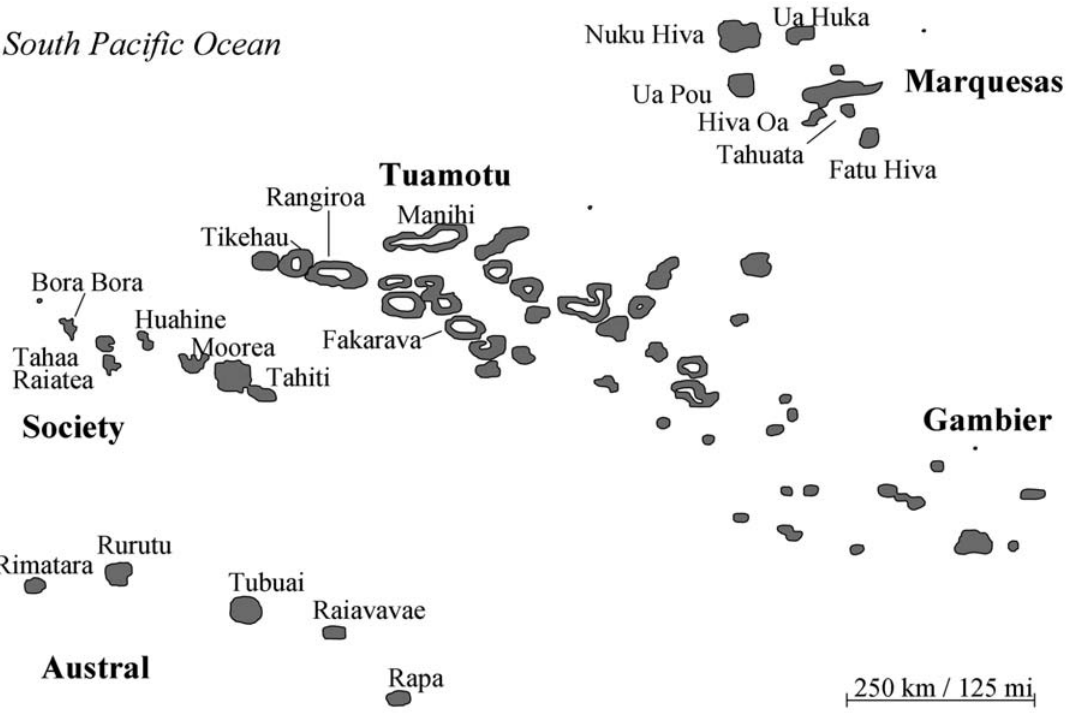
Figure 1. Map of French Polynesia (FP). Sampling of DENV-1 sera was conducted in the five FP archipelagos: Society, Tuamotu, Gambier, Austral and Marquesas. doi:10.1371/journal.pntd.0000493.g001 Table 1. Geographical and clinical characteristics of the 181 DENV-1 sera used for E-gene sequence analysis.